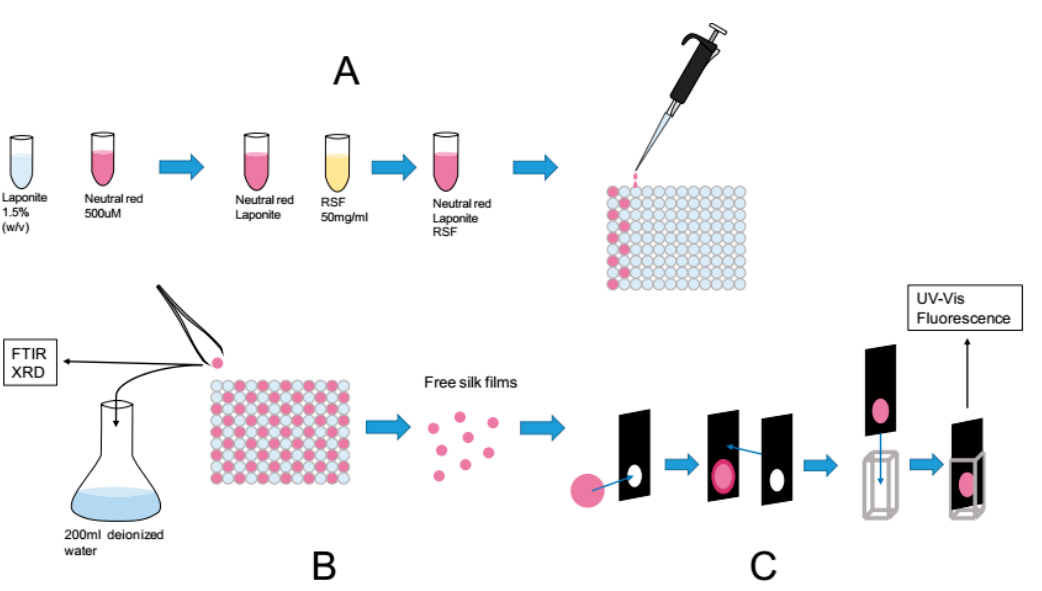
Figure 4. Summary of procedures for the fabrication and characterization of chromogenic silk patches: ( A ) Mixing and casting of RSF/Laponite ® /Dye solution; ( B ) After overnight drying the ready patch were tested by FTIR and XRD; and, immersed in 200 mL deionized water to test the dye leakage; ( C ) Custom built holder for the silk patch fitting in a 1 cm standard cuvette. The chosen geometry allows UV absorbance and fluorescence spectra to be collected in solution and without disruption of the sample. Scale: the silk patches are standardized to a diameter of 8 mm.